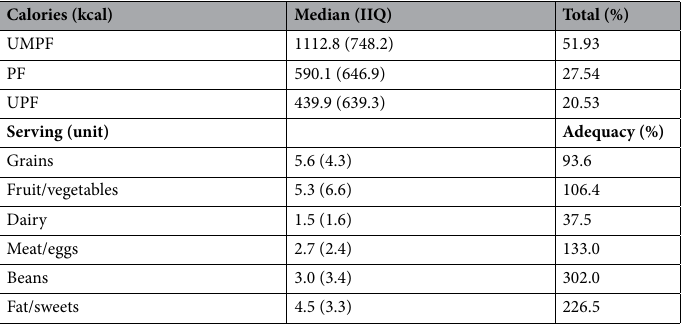
Table 2. Profile distribution of food group consumption Interquartile range (IQR). UMPF Unprocessed and minimally processed food, PF processed food, UPF ultra-processed food, Grains foods rich in carbohydrates such as rice, pasta, bread, crackers, corn, potato and other tubers, Fruits/vegetables fruits, leaves and vegetables, Dairy cheese, milk and yoghurts, Meat/eggs animal-based protein including eggs and chicken, cow and pork meat, Beans foods rich in vegetable protein such as beans, soy and peas, Fats/sweet sugars, sweets, desserts and candies, oils, pork lard, butter and margarine. Servings considered adequate for each food group were: grains = 6, beans = 1, fruits and vegetables = 5, Meat/eggs = 2, Dairy = 4, Fat and Sweets (FS) = 2.